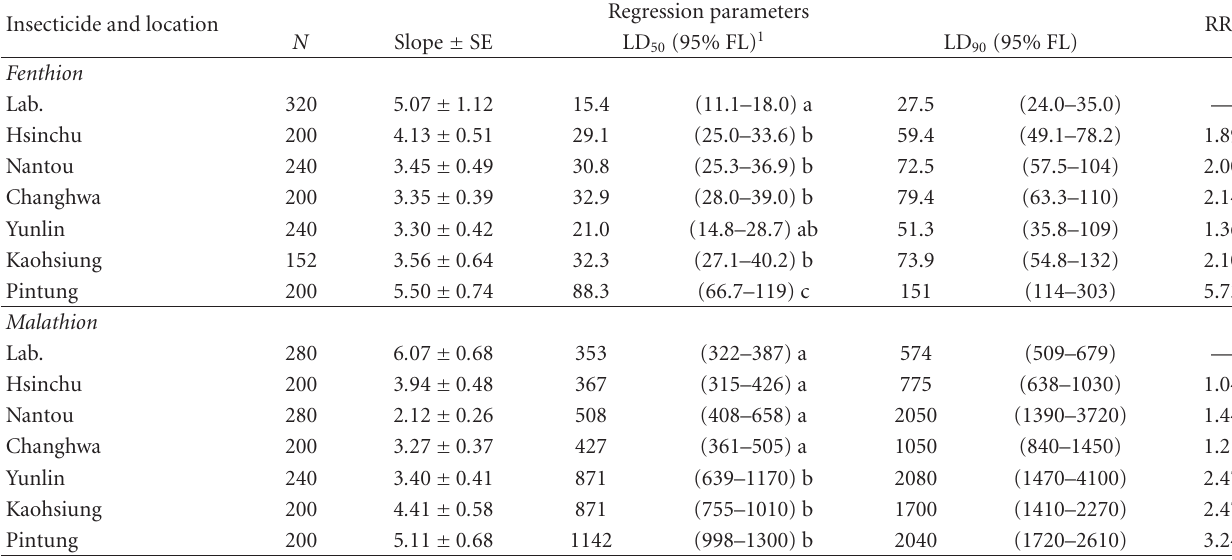
Table 5: Susceptibility of field populations of B. cucurbitae , collected during 2007 in Taiwan, to spinosad and other insecticides analyzed by topical application assay at 24hr after